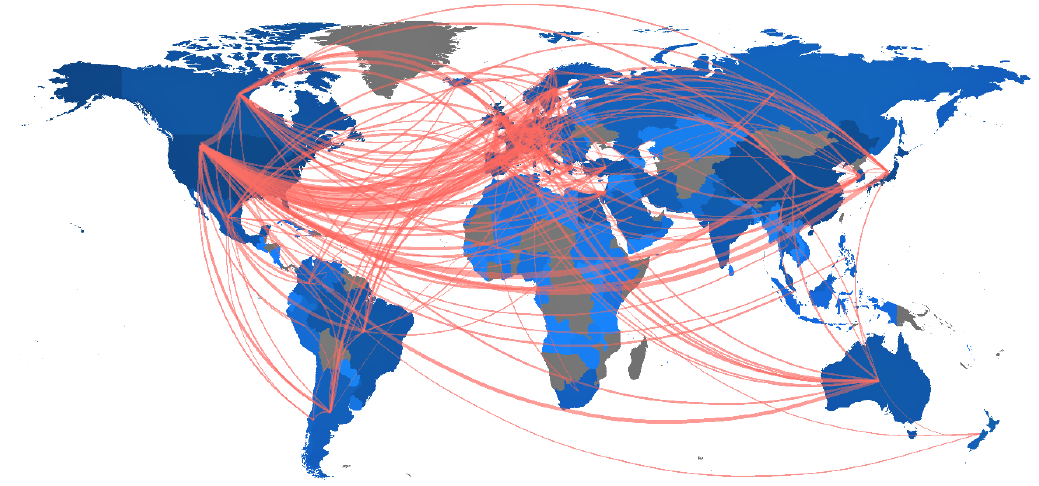
Figure 5. A world map of international research collaboration in original articles on systemic lupus erythematosus from 1971 to 2020.